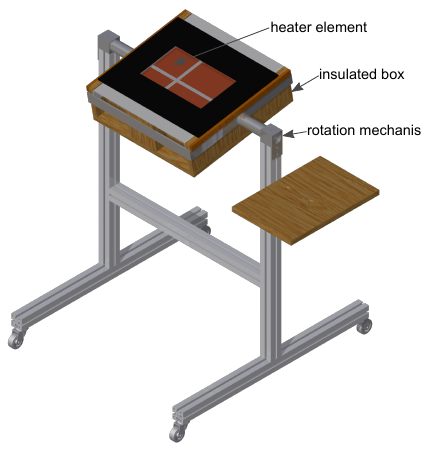
Figure 3. Overview of the experimental setup.